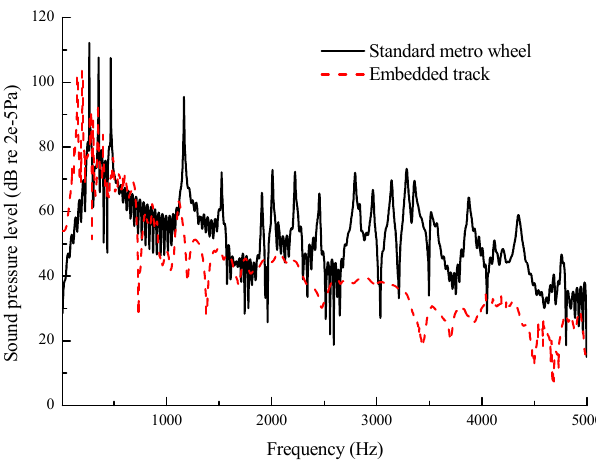
Figure 17. SPL compare between standard metro wheel and embedded track (simulation results).